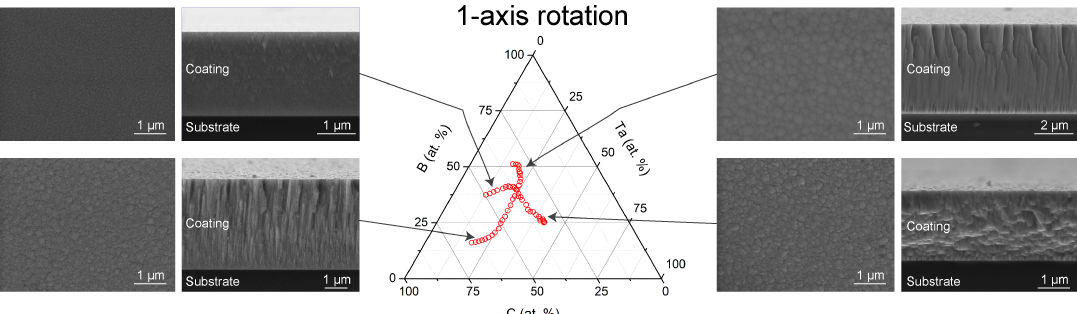
Figure 5. SEM images of surface morphology and unpolished cross-sections of stationary samples.